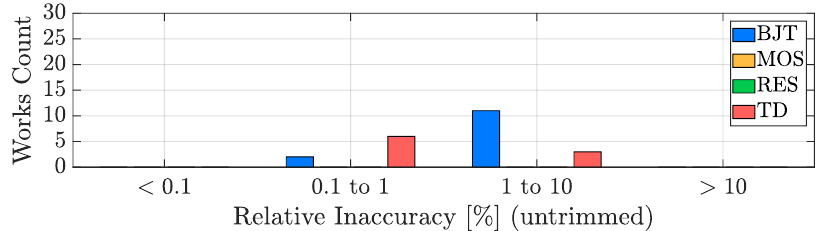
Figure 13. Untrimmed TDC inaccuracy performance distribution with sensing-type